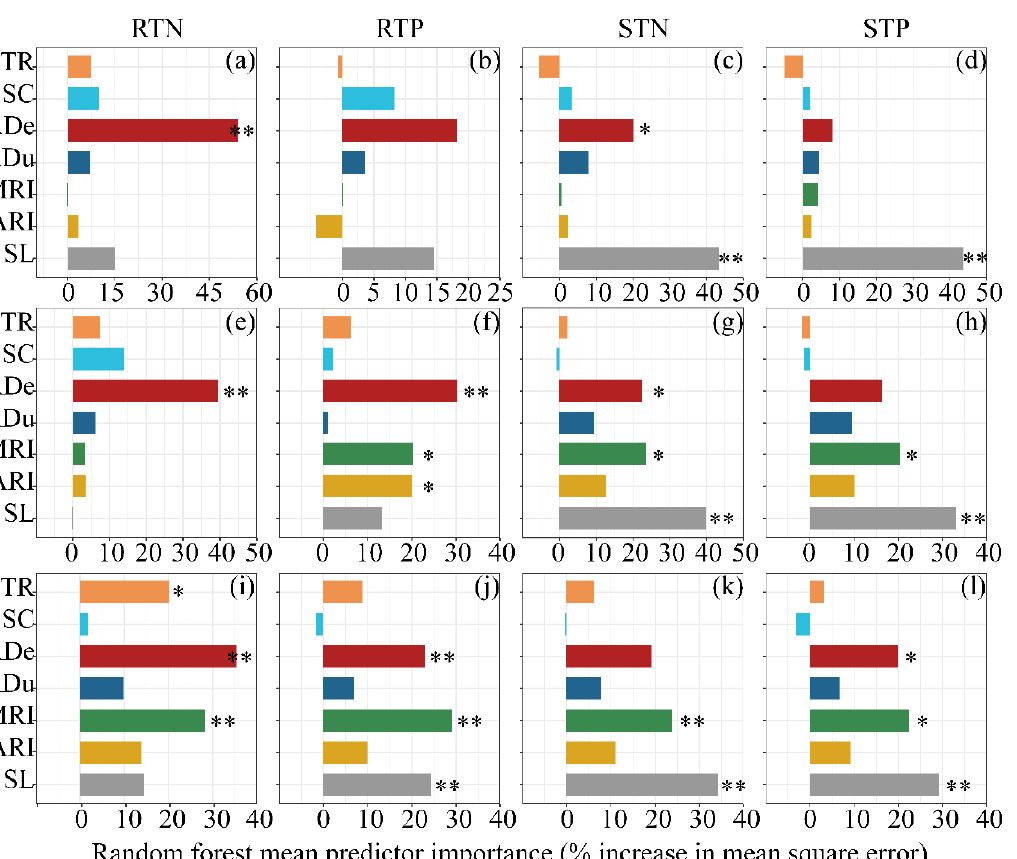
Figure 6. Random forest mean predictor importance (% increase in mean square error) of the factors influencing ( a ) total nitrogen in runoff (RTN), ( b ) total phosphorus in runoff (RTP), ( c ) total nitrogen in soil loss (STN), and ( d ) total phosphorus in soil loss (STP) for spring corn, ( e – h ) winter wheat, and ( i – l ) fallow plots, respectively. TR: total rainfall; SC: soil condition (including soil nutrients, bulk density, and saturated hydraulic conductivity); RDe: runoff depth; RDu: rainfall duration; MRI: maximum rainfall intensity; ARI: average rainfall intensity; SL: soil erosion. *, p < 0.05; **, p < 0.01.